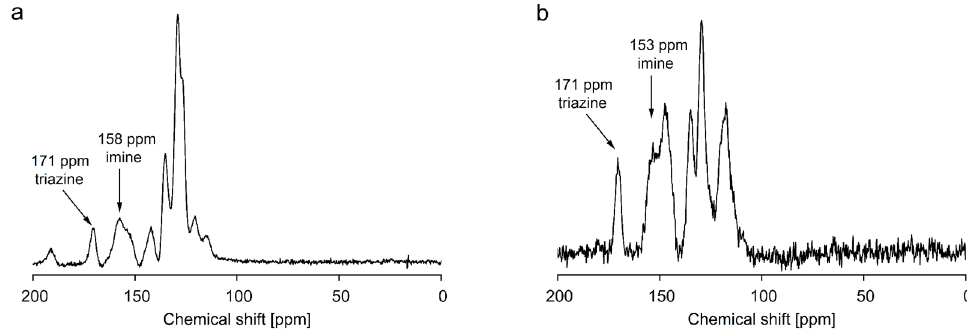
Figure 1. 13 C CP MAS NMR spectra of ( a ) HHU-COF-1 and ( b ) HHU-COF-2. Spectra were obtained at 150 MHz, cross-polarization with decoupling spinal and 35 kHz spinning.